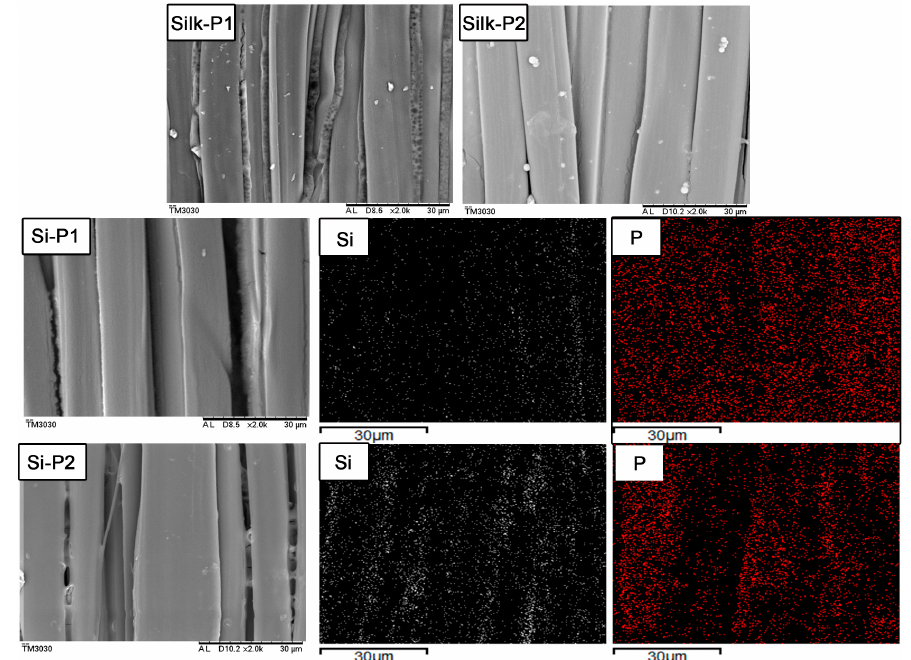
Figure 3. SEM magnifications of Silk-P 1 , Silk-P 2 and Si-P 1 and Si-P 2 samples and elemental analysis of Si-P 1 , Si-P 2 samples. Table 1. Elemental analysis of the pure silk and the treated silk fabrics.